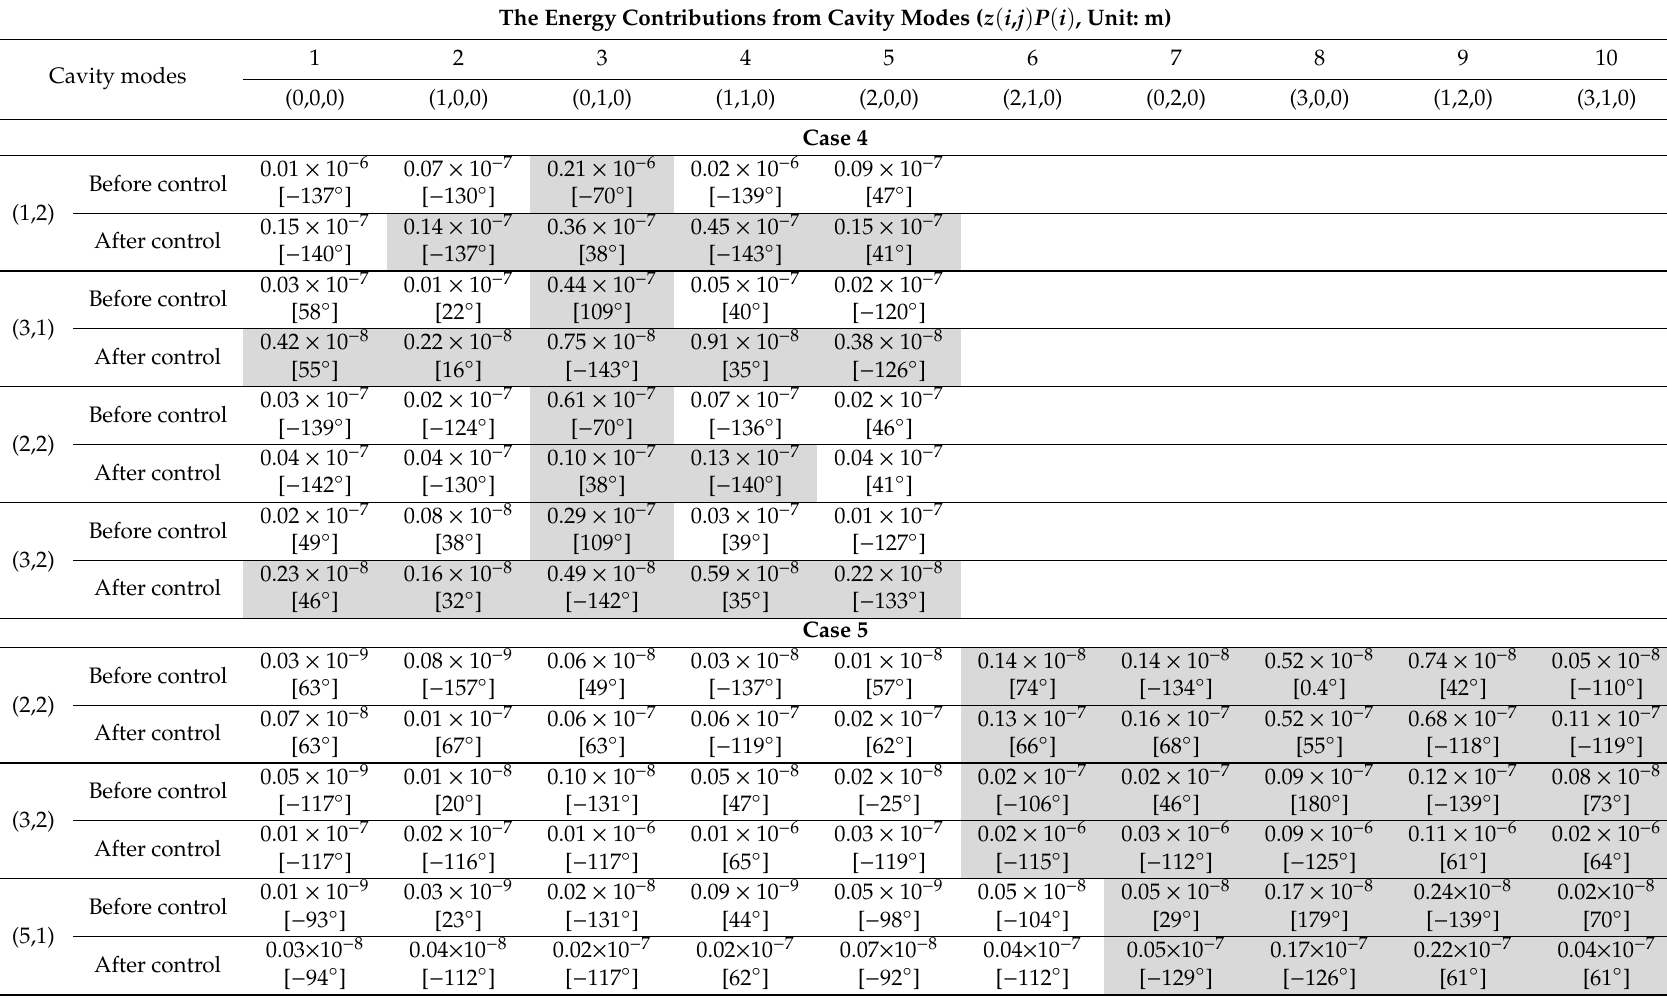
Table 7. The energy contributions of the cavity modes to the base plate B modes. The Energy Contributions from Cavity Modes ( z ( i , j ) P ( i ) , Unit: